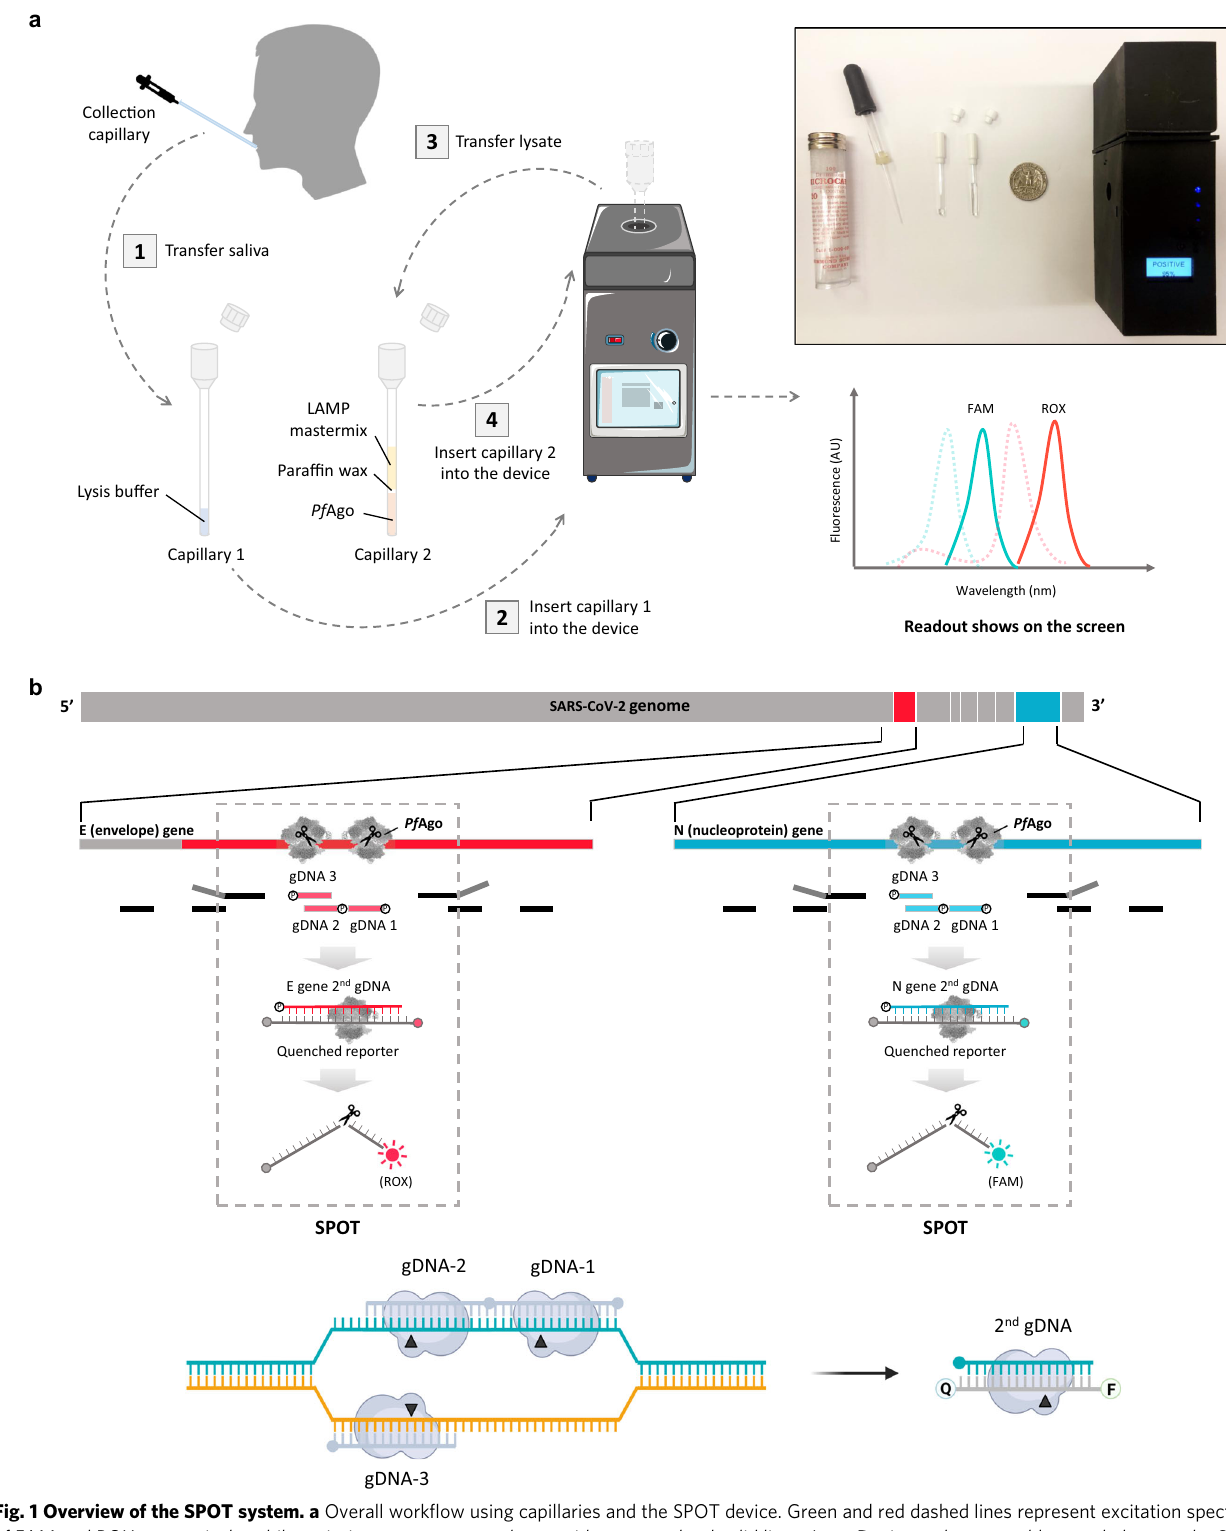
Fig. 1 Overview of the SPOT system. a Overall work fl ow using capillaries and the SPOT device. Green and red dashed lines represent excitation spectrum of FAM and ROX, respectively, while emission spectrums are shown with green and red solid lines. Inset : Device and consumables needed to run the SPOT system, including a 3D printed portable detection device, a prefabricated sample pretreatment capillary 1, a prefabricated viral RNA detection capillary 2, and collection capillaries. A quarter coin is placed for scale (diameter: 24.26 mm); b Genome map showing primers, gDNAs, and SPOT mechanism. RT- LAMP primers are indicated by black rectangles. Enclosed “ P ” represents the phosphate group. Pf Ago cleavage sites are shown in black triangles, enclosed “ Q ” represents quencher group and enclosed “ F ” represents fl uorophore